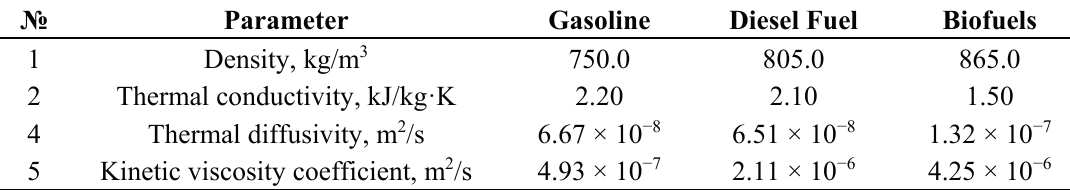
Table 1. Physical parameters of the fuels.